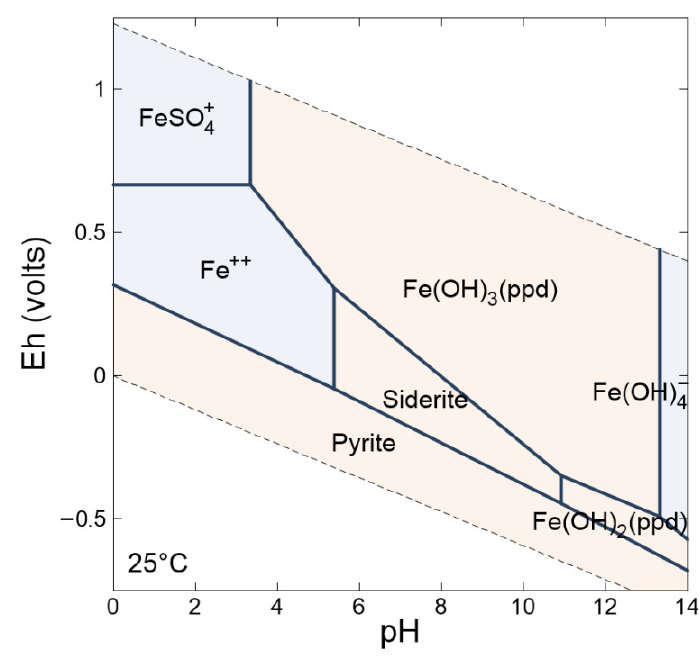
Figure A28. High iron 20 mg/L, Ca 5 mM (200 mg/L), bicarbonate 7 mM (427 mg/L), sulfate 4 mM (384 mg/L), and chloride 2 mM (71 mg/L).